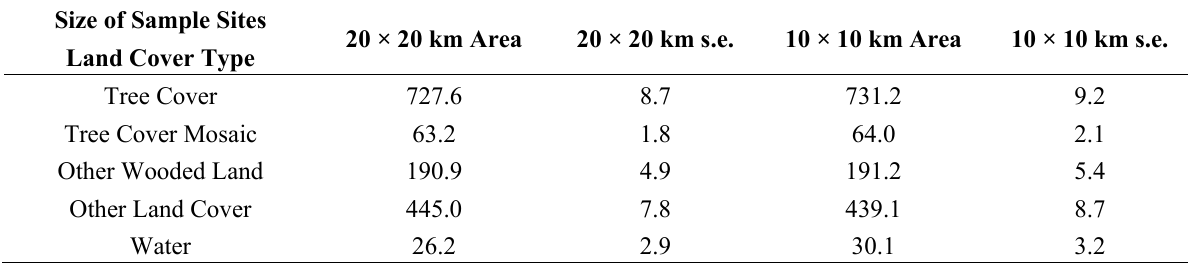
Table 1. Comparison of land cover estimates for year 1990 for South & Central America when using 20 km × 20 km and 10 km × 10 km sample sites (in 10 6